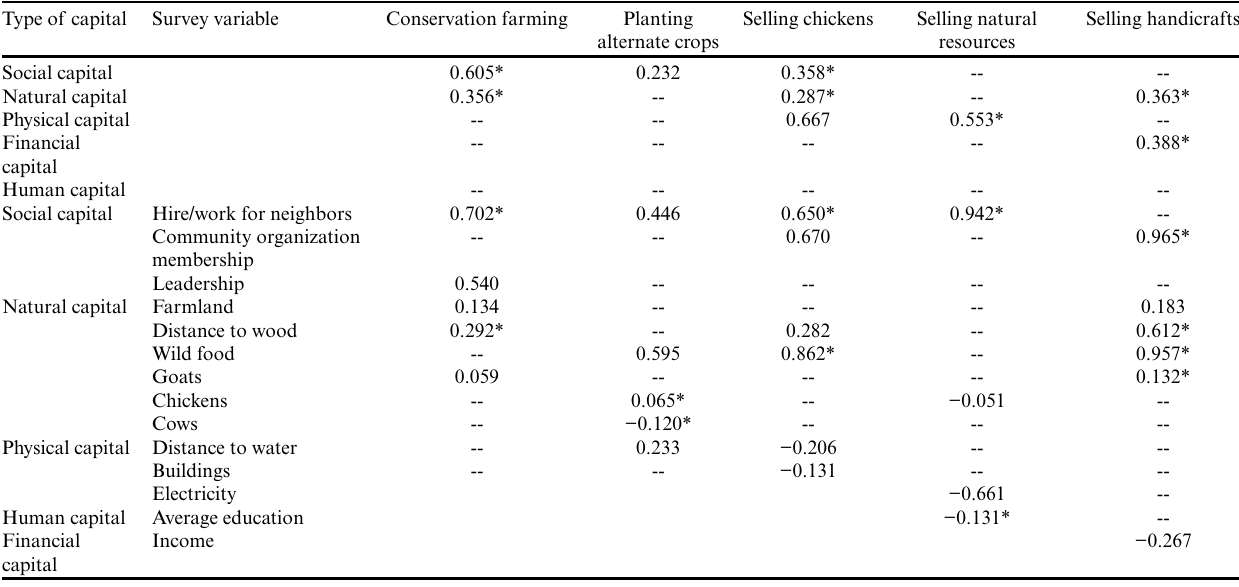
Table 3. Results of logistic regressions for attempts of each adaptation. The table shows model-averaged beta estimates and their significance for all variables in the top competing model for each adaptation. We show results from models that included each type of capital and for individual capital variables, grouped according to